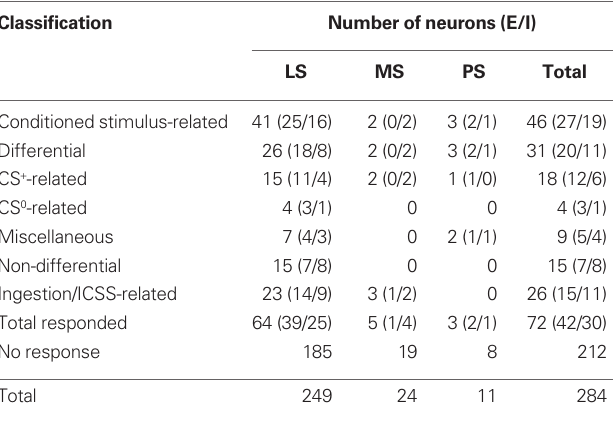
Table 2 | Classification of the neurons recorded in the septal